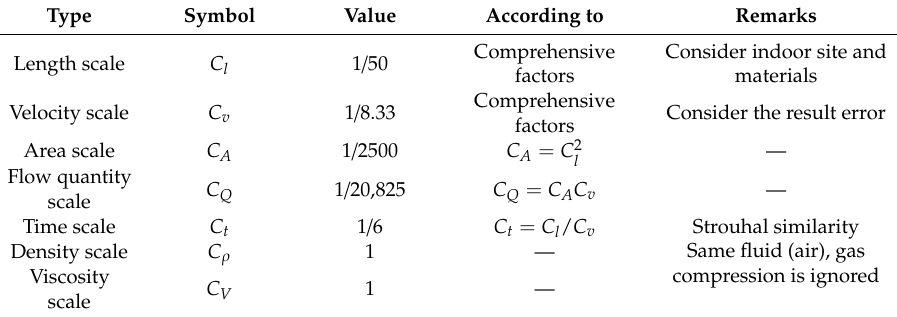
Table 1. Similarity scales in the model